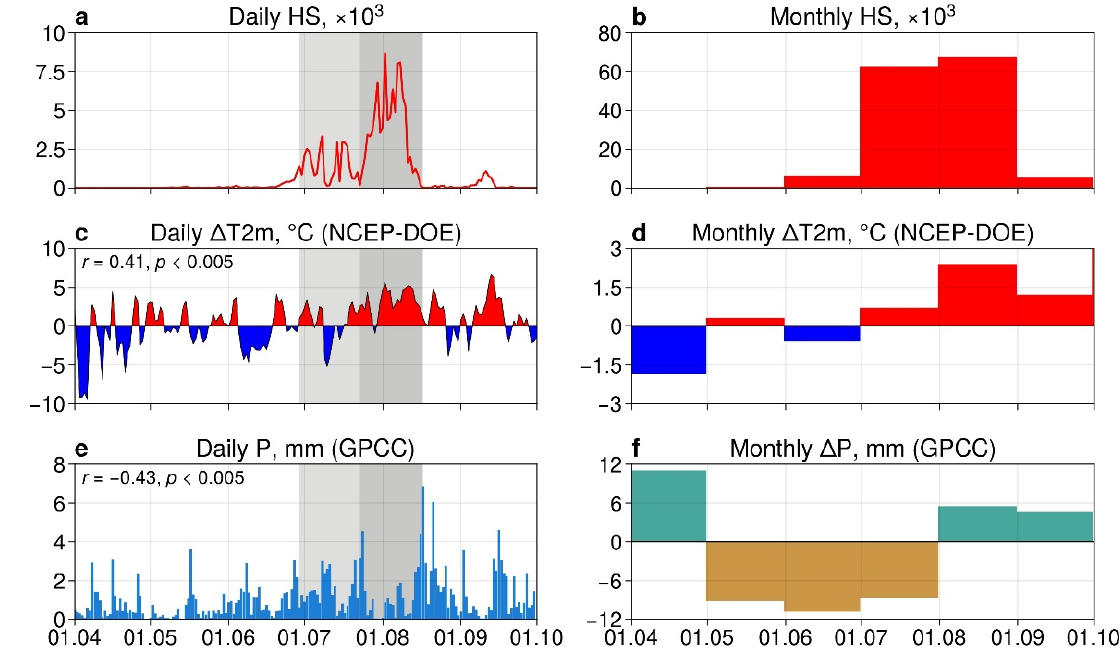
Figure 3. ( a ) Daily and ( b ) monthly number of HS; ( c ) daily and ( d ) monthly anomalies of air temperature; ( e ) daily total and ( f ) monthly anomalies of precipitation. Grey vertical bars indicate two periods of wildfire activity. All data correspond to the study region. Correlation coefficients on figures ( c , e ) indicate correlation between the number of HS and the corresponding parameter during the period from 29 June to 17 August.